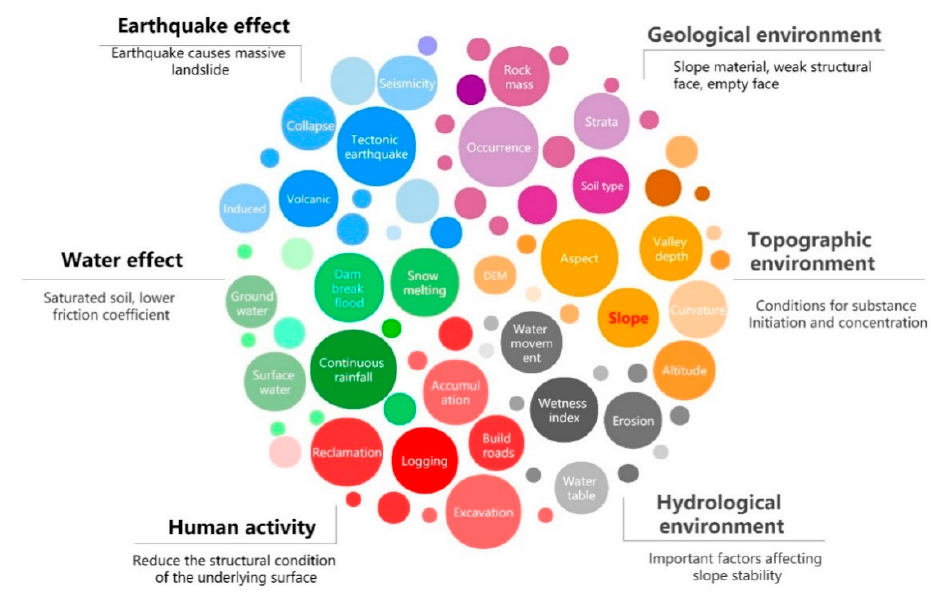
Figure 15. Landslide influencing factors commonly considered in the literature.